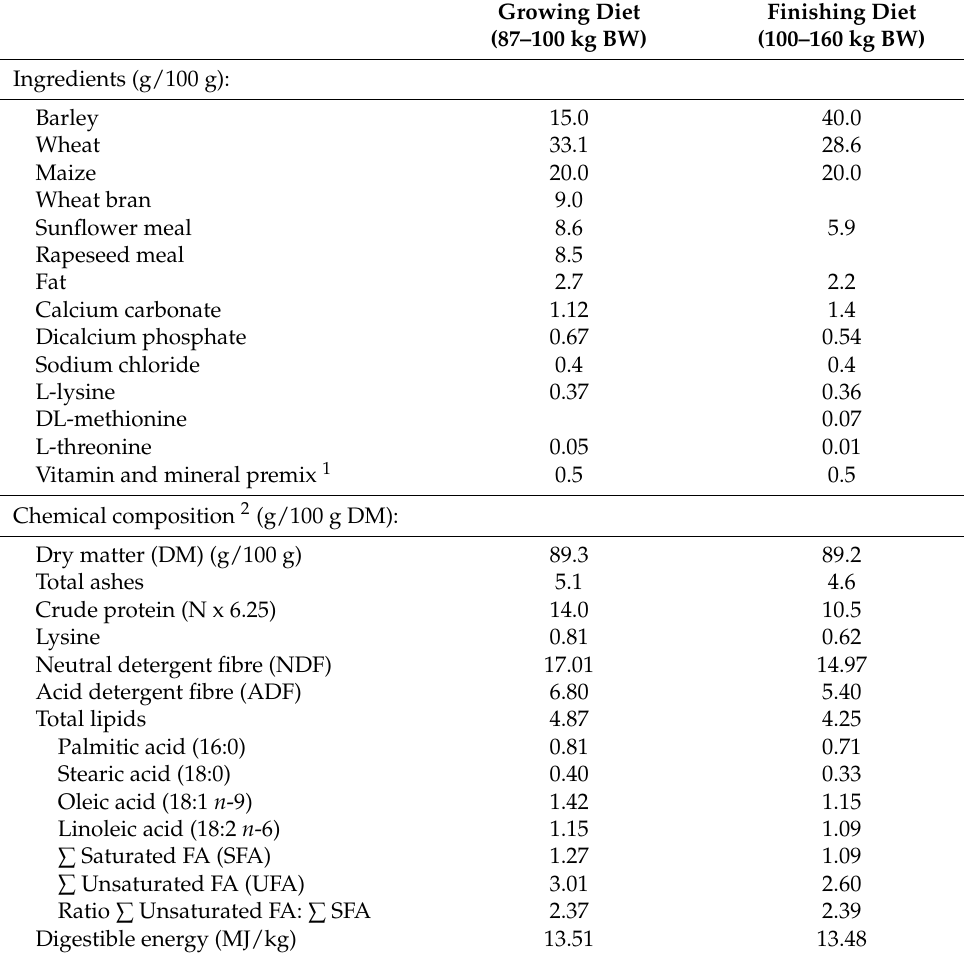
Table 1. Ingredients, chemical and main fatty acid composition of the experimental